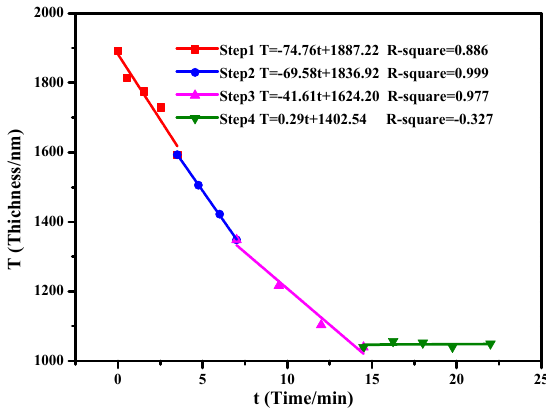
Figure 2. Change of dielectric thickness after RIE steps 1–4.